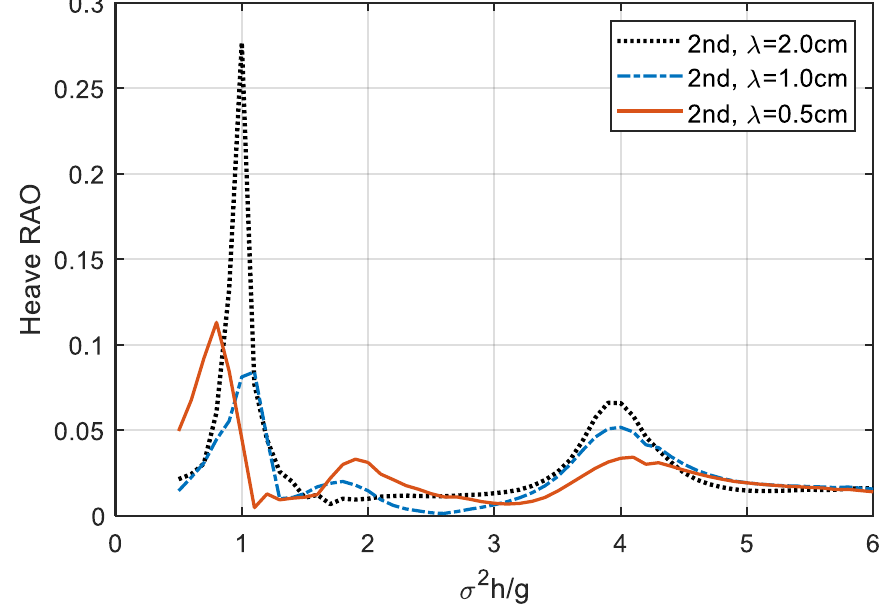
Figure 13. Comparison of the second-order heave RAO of the floating platform with di ff erent fishnet mesh